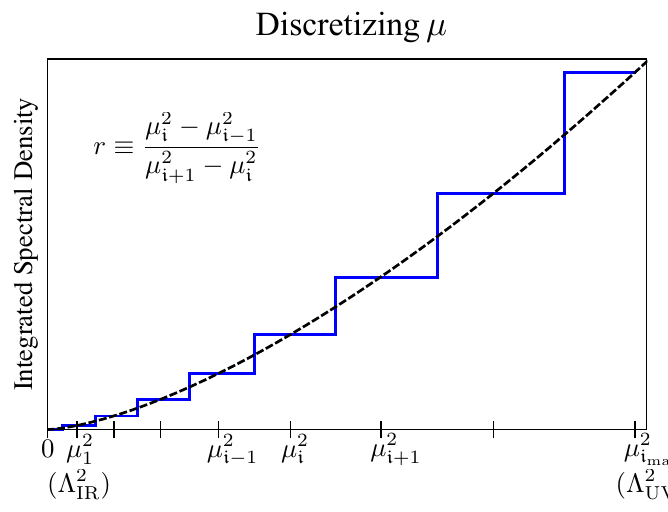
Figure 2 . Schematic representation of the integrated spectral density (see (3.7)) of a generic operator O in the undeformed CFT, with our choice of µ discretization (3.3) (blue line), compared to the exact expression (black dashed line). There are i bins, each with constant support on max the intervals [ µ 2 ] . The largest value µ 2 sets the UV cutoff, and the lowest value µ 2 sets the , µ 2 1 i − 1 i i max IR resolution (see (3.8)). The parameter r controls the relative width of successive bins, such that r = 1 corresponds to uniform bins, and r < 1 has smaller bins in the